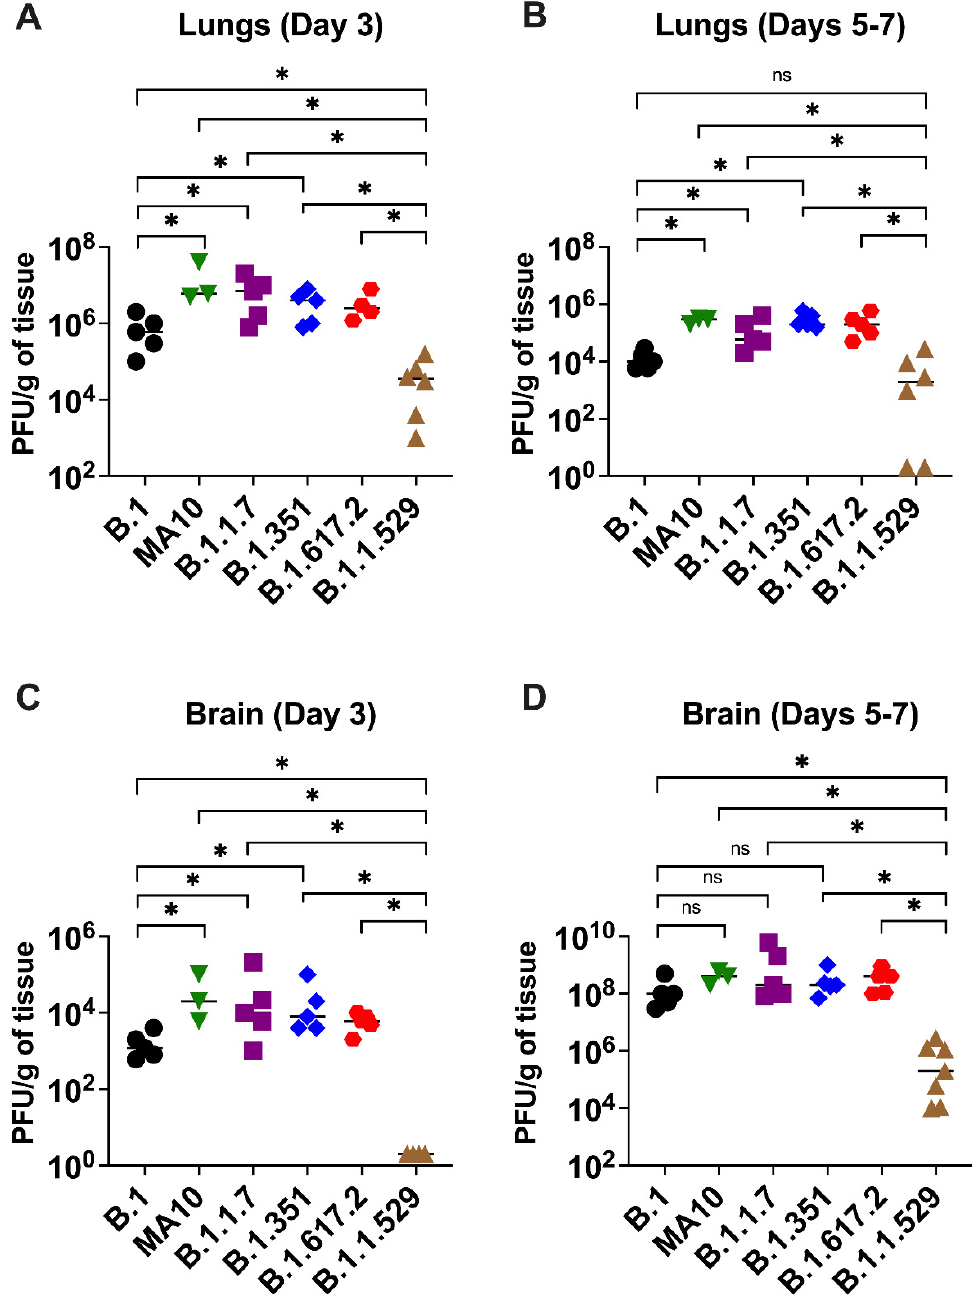
Figure 2. Replication of SARS-CoV-2 VoC in the lungs and brain. Eight-week-old K18-hACE2 mice were inoculated intranasally with 10 4 PFU of SARS-CoV-2 or variants. Groups of 3–7 mice were euthanized on day 3 and days 5–7 after infection, and tissues were collected. Virus titers were analyzed in the lungs and brain by plaque assay. The data are expressed as PFU/g of tissue. ( A ) Virus titer in day 3 lungs, ( B ) virus titer in day 5–7 lungs, ( C ) virus titer in day 3 brain, and ( D ) virus titer in day 5–7 brain. Each data point represents an individual mouse. *, p < 0.05.